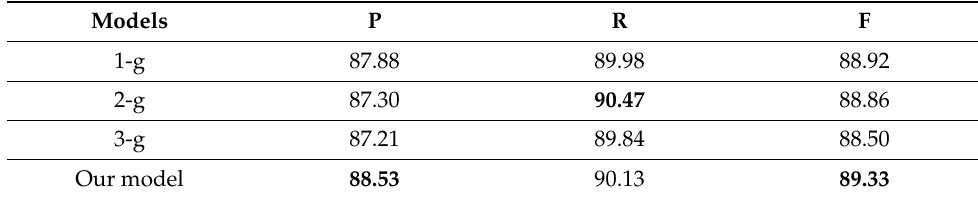
Table 5. Performance comparison between different n-gram lengths with our model.